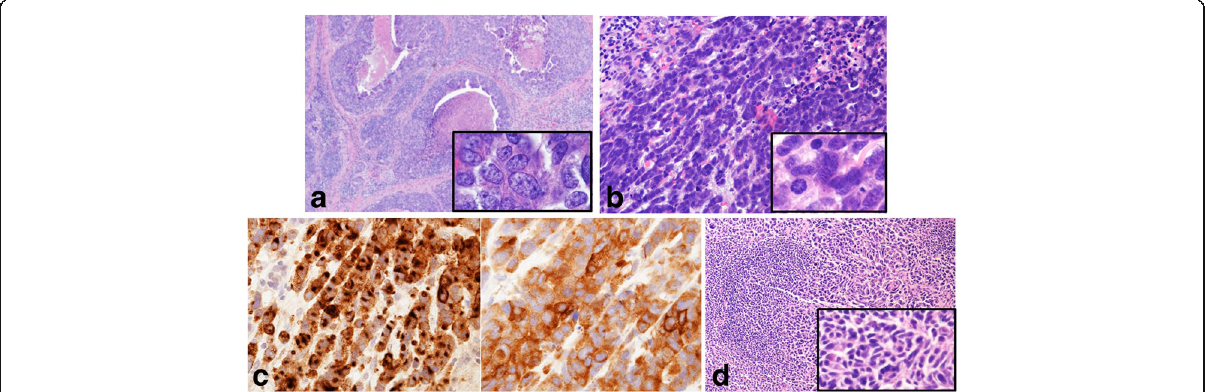
Fig. 1 Microscopic findings of resected specimen. a The tumor cells of invasive ductal carcinoma show round to oval hyperchromatic nuclei with prominent nucleoli. b The tumor cells of neuroendocrine features have small scant cytoplasm and finely granular hyperchromatic nucleus without nucleoli. c The tumor cells are highly immunopositive for both chromogranin A (left) and synaptophysin (right). d The metastasis of axillary lymph node is caused